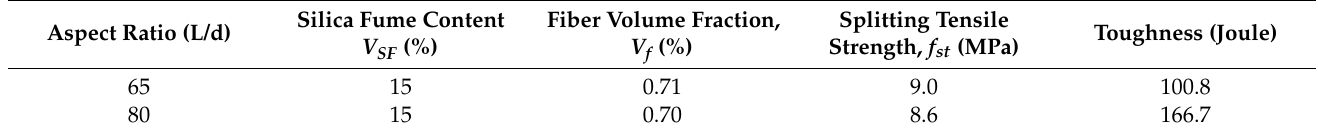
Table 3. Optimum values for silica fume content and steel fiber volume fraction.